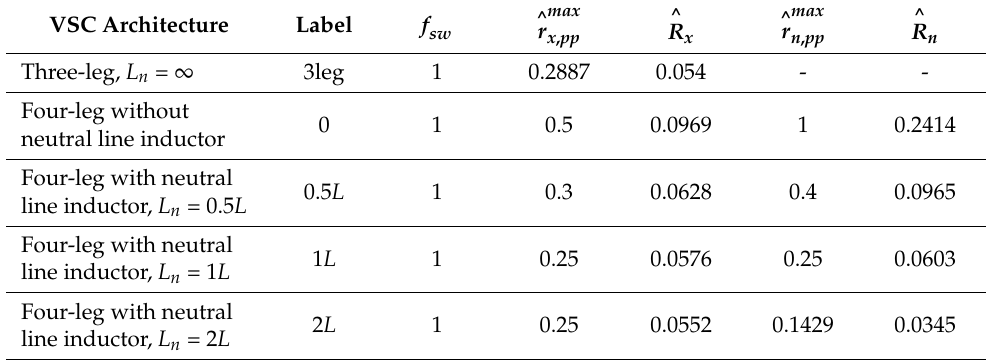
Table 2. Current-ripple-related data for the case of the same switching frequency ϕ = 0 and m = 0.5. VSC